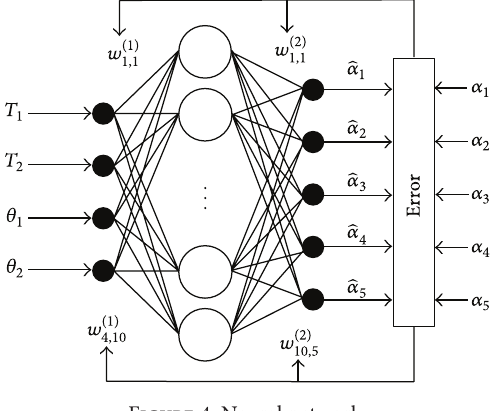
Figure 4: Neural